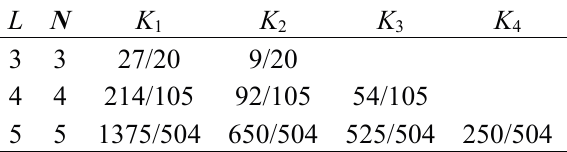
Table 1. FTSc algorithm coefficients.